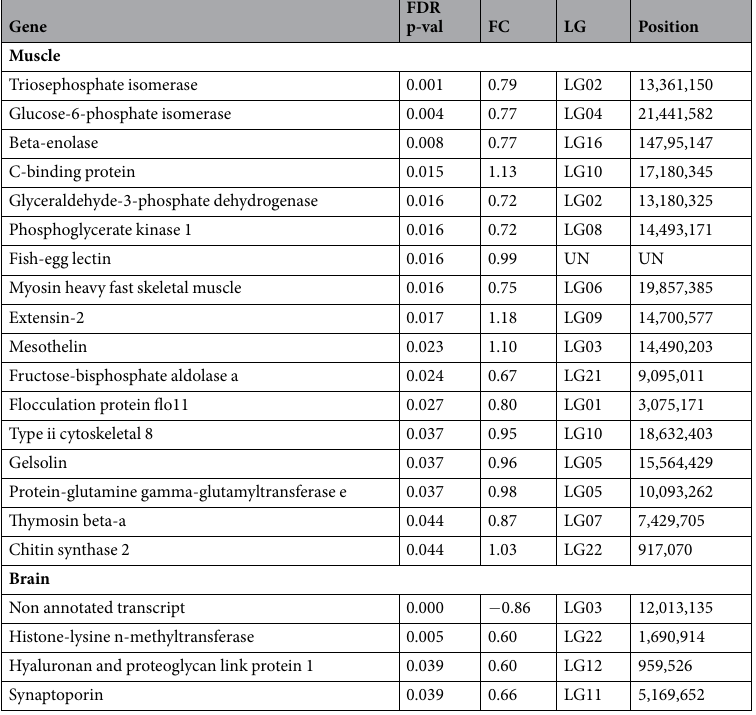
Table 2. Differentially expressed genes between fast- and slow-growing turbot. FDR p-val: false discovery rate corrected p-value; FC: log2 fold change; LG: linkage group; UN: gene located in a scaffold not assigned to a LG of the turbot genetic